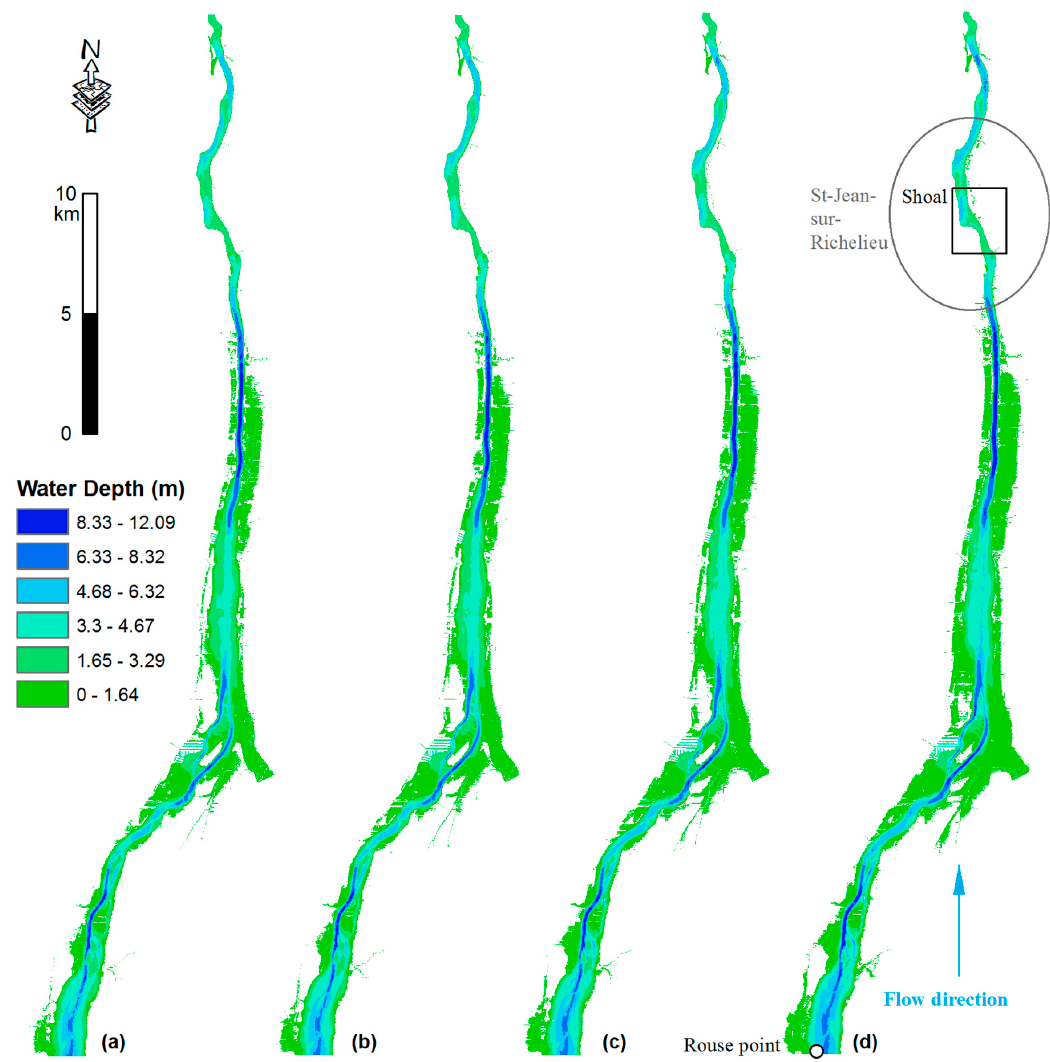
Figure 4. Predicted water depth with the two-dimensional (2D) hydraulic model for flow cases of 759 m 3 /s ( a ), 824 m 3 /s ( b ), 936 m 3 /s ( c ), and 1113 m 3 /s ( d ) for nominal values of the topography and Manning’s n coefficient.